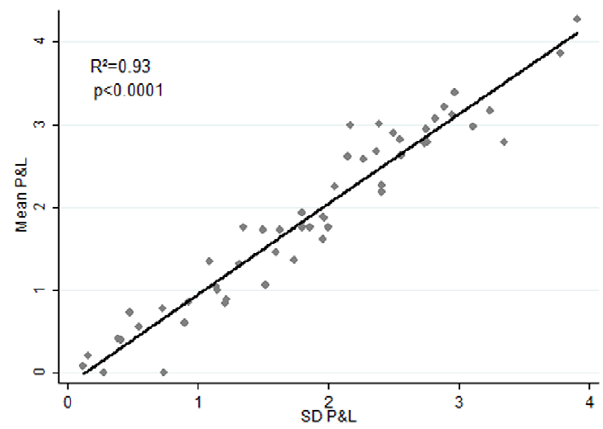
Figure 1. P&L vs. Risk. Plot of traders’ P&L against the standard deviation of their P&L. The curve is linear. The intercept is 0, rather than the risk free rate, because returns are zero when the traders do not trade. As P&L data is heavily skewed to the right, we employed a Box- Cox transformation of the P&L to normalise it (SI). The curve is also linear when plotted with raw and log transformed data, as predicted by the Efficient Market Hypothesis.